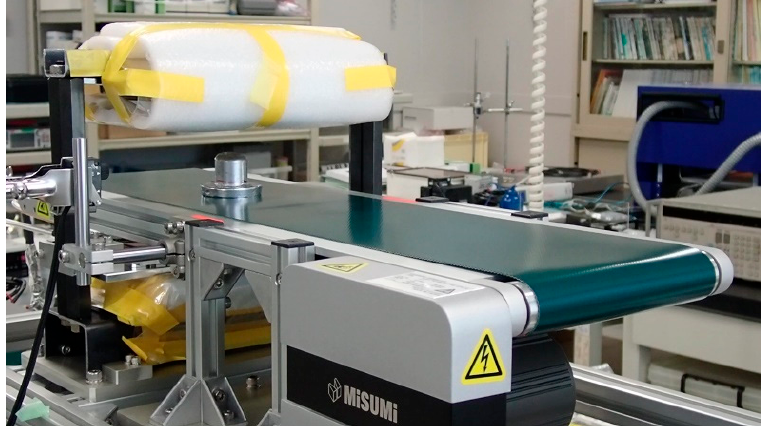
Figure 2. Picture of the prototype system with the conveyer.